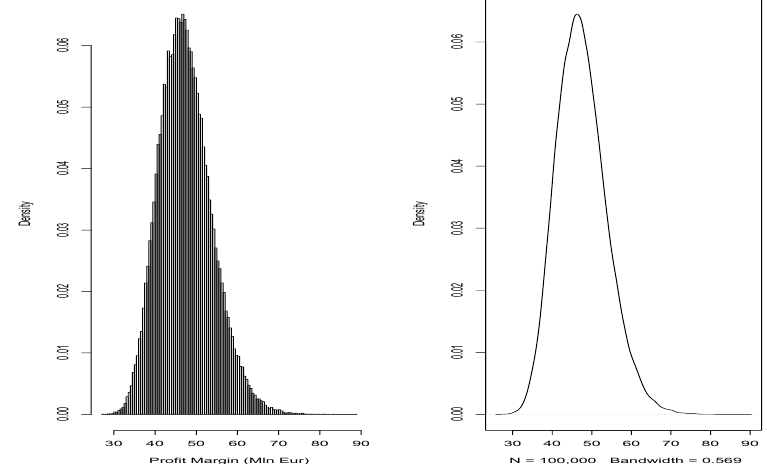
Figure 13. Empirical probability distribution of V (cid:48) ( t , X ( s )) .